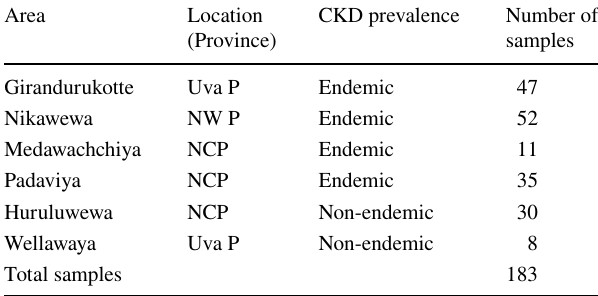
Table 2 Secondary data from CKDu endemic and non-endemic area (Chandrajith et al.